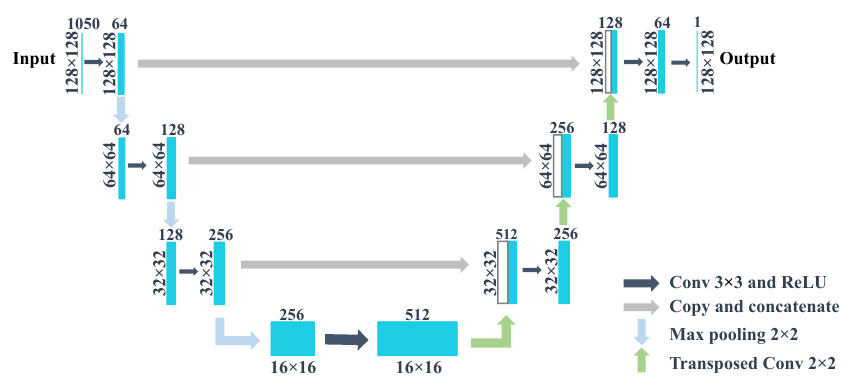
Figure 6. U-Net architecture.